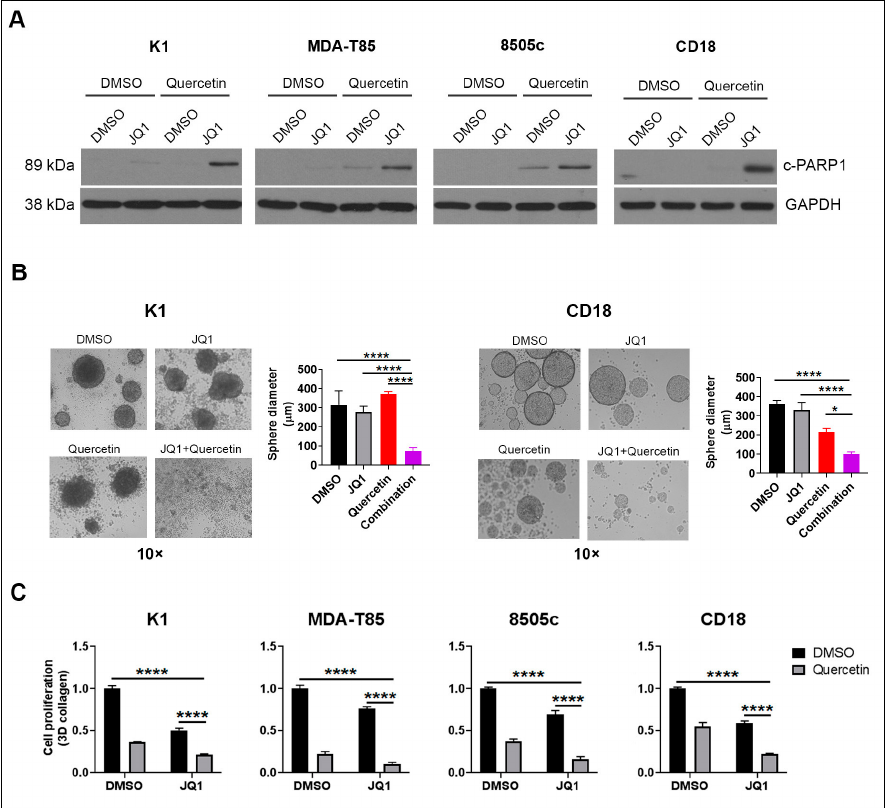
Figure 1. Quercetin enhances the anti-tumor effects of bromodomain and extraterminal domain (BET) inhibitors. ( A ) Thyroid and pancreatic cancer cells were treated with DMSO (control), JQ1 (1 µmol/L), Quercetin (20 µmol/L), or a combination of JQ1 (1 µmol/L) and Quercetin (20 µmol/L) for 24 h. The effect on apoptosis was determined by analyzing for c-PARP1 by western blot analysis, using GAPDH as loading control. ( B ) Thyroid K1 and pancreatic CD18 cancer cells were grown in suspension cultures in the presence of DMSO, JQ1 (1 µmol/L), Quercetin (20 µmol/L), or a combination of JQ1 (1 µmol/L) and Quercetin (20 µmol/L) for 72 h. The ability of cancer cells to form tumor spheres was examined by phase microscopy. The results are representative of at least three independent experiments. Error bars represent SD from at least three technical replicates. Two-way ANOVA analysis was performed. Comparison was made against the combined treatment group. *, p < 0.05; ****, p < 0.0001. ( C ) Thyroid and pancreatic cancer cells growing in 3D collagen were treated with DMSO, JQ1 (1 µmol/L), Quercetin (20 µmol/L), or combination of JQ1 (1 µmol/L) and Quercetin (20 µmol/L) for 72 h. The effect on proliferation was determined by WST-1 assay. Two-way ANOVA analysis was performed. ****, p < 0.0001. Error bars represent SD from three technical replicates. Results are representative of two to four independent experiments. DMSO: dimethyl sulfoxide; JQ1: BET inhibitor; c-PARP1: cleaved PARP; GAPDH: Glyceraldehyde 3-phosphate dehydrogenase (loading control); K1, MDA-T85: human papillary thyroid cancer cell lines; 8505c: human anaplastic thyroid cancer cell line; CD18: human pancreatic cancer cell line; SD: standard deviation; WST-1: tetrazolium salt converted by cellular mitochondrial dehydrogenases to formazan.